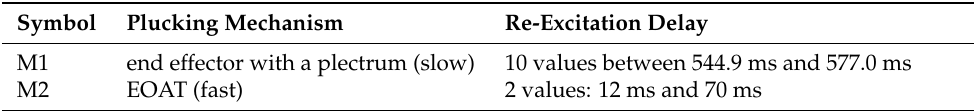
Table 1. Description of robot-assisted experiments with symbols representing them for brevity in the following sections.